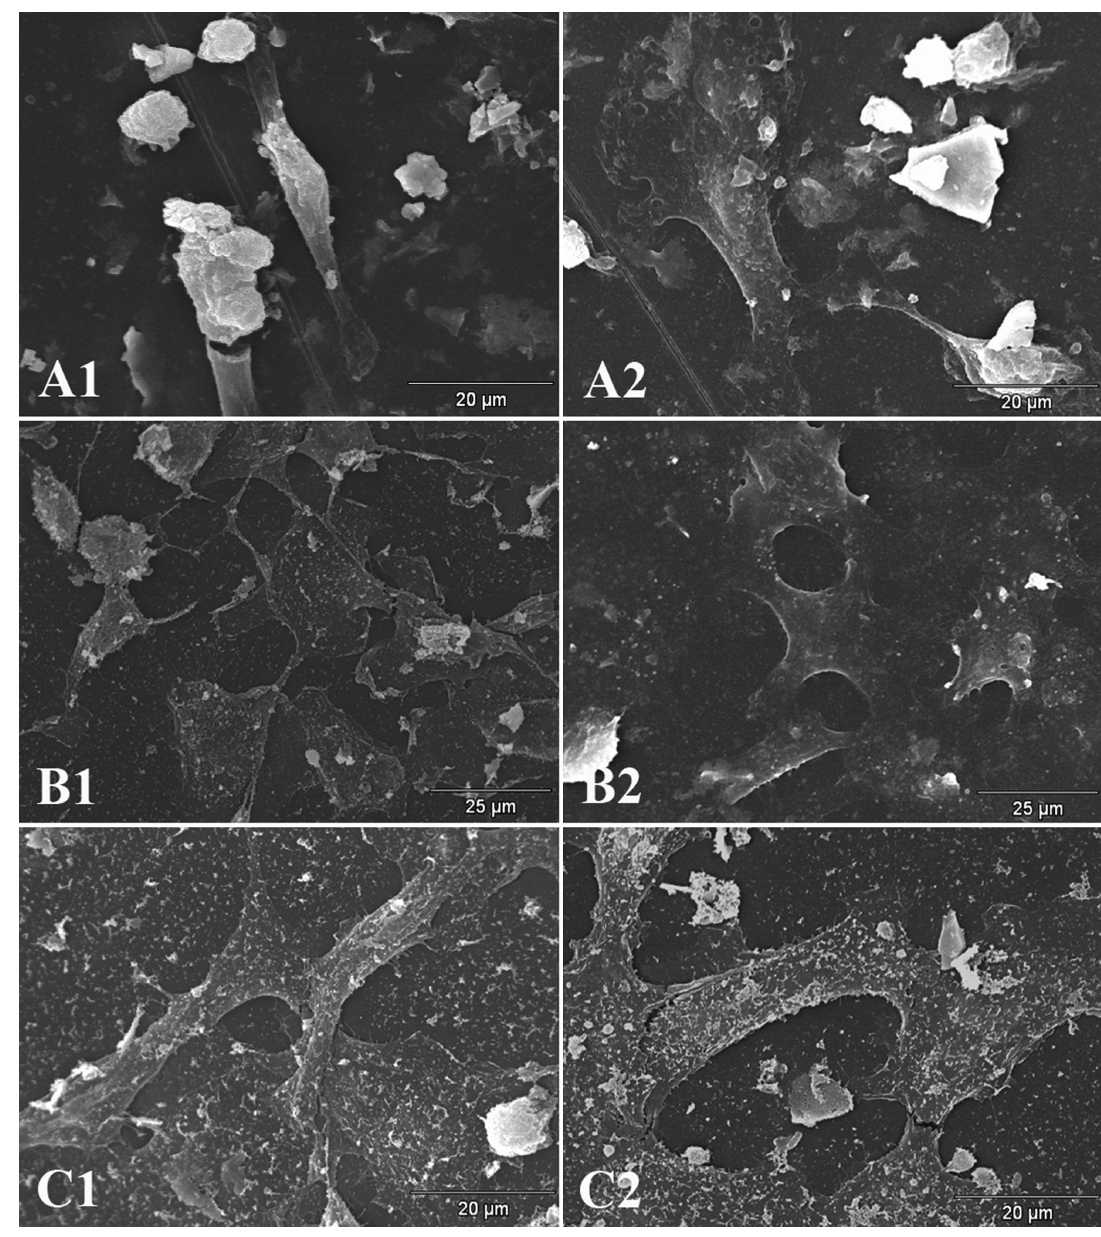
Figure 5. Morphology of Vero cells cultured on different chitosan membranes, obtained by scanning electron microscopy. (a) Chitosan membrane (CA); (b) Chitosan neutralized membranes (CN); (c) Chitosan plasticized membranes